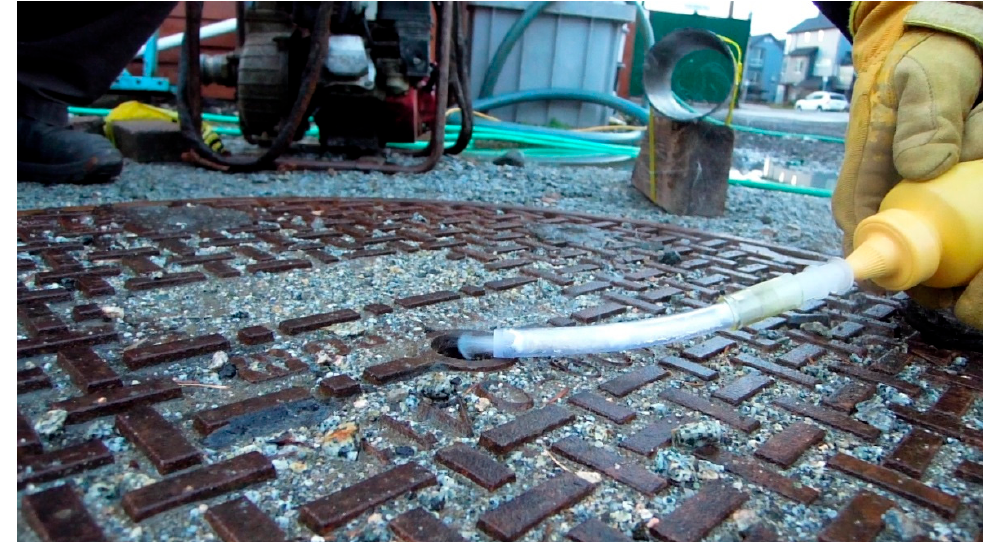
Figure 6. Entry of ‘smoke’ into the single opening in the manhole cover. On this occasion, the change in direction from horizontal to downward was apparent. These changes in direction were very brief and difficult to capture in a photo.